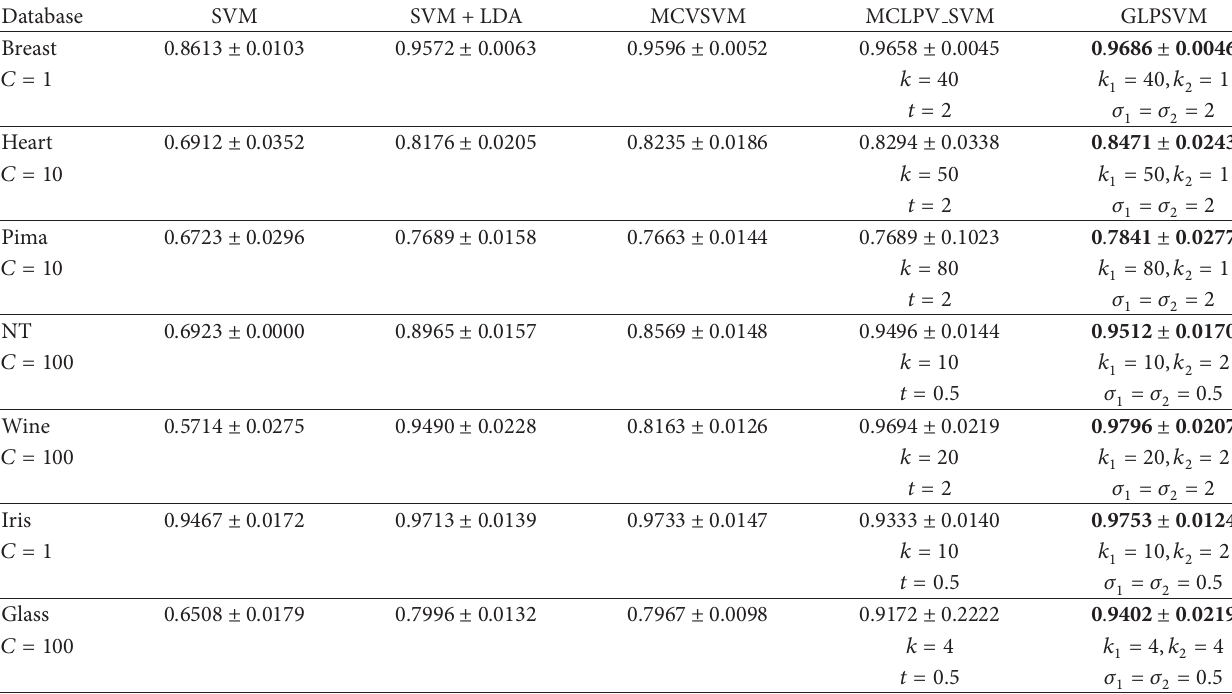
Table 4: Classification accuracy for comparative